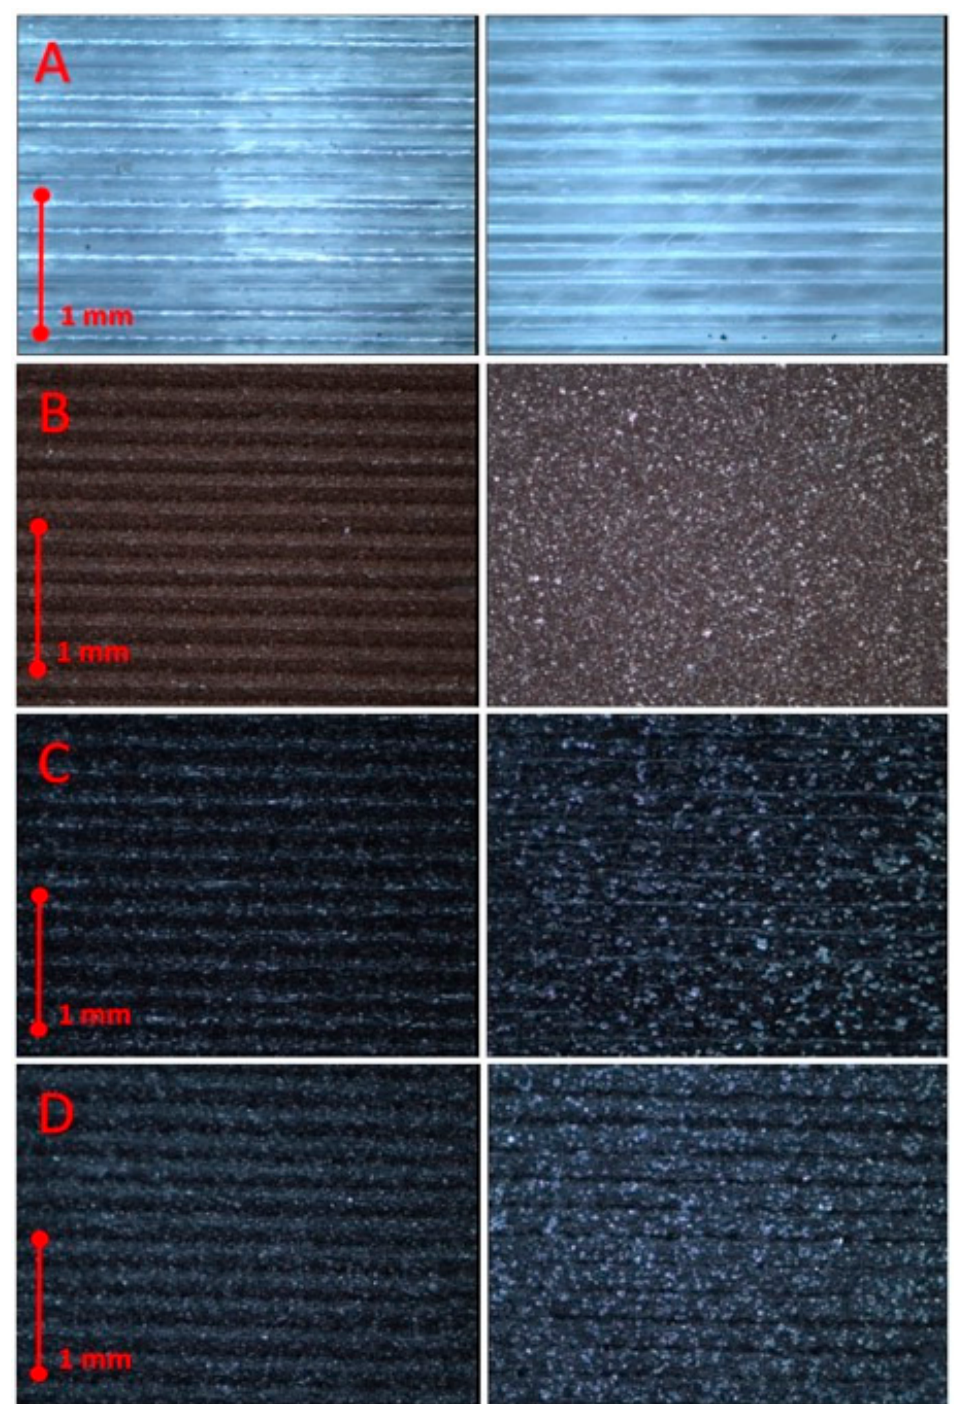
Figure 19. Sidewall of test specimens with 0.2 layer height, before and after grinding ( A ) Pure PLA, ( B ) Copper, ( C ) Iron, ( D ) Steel.